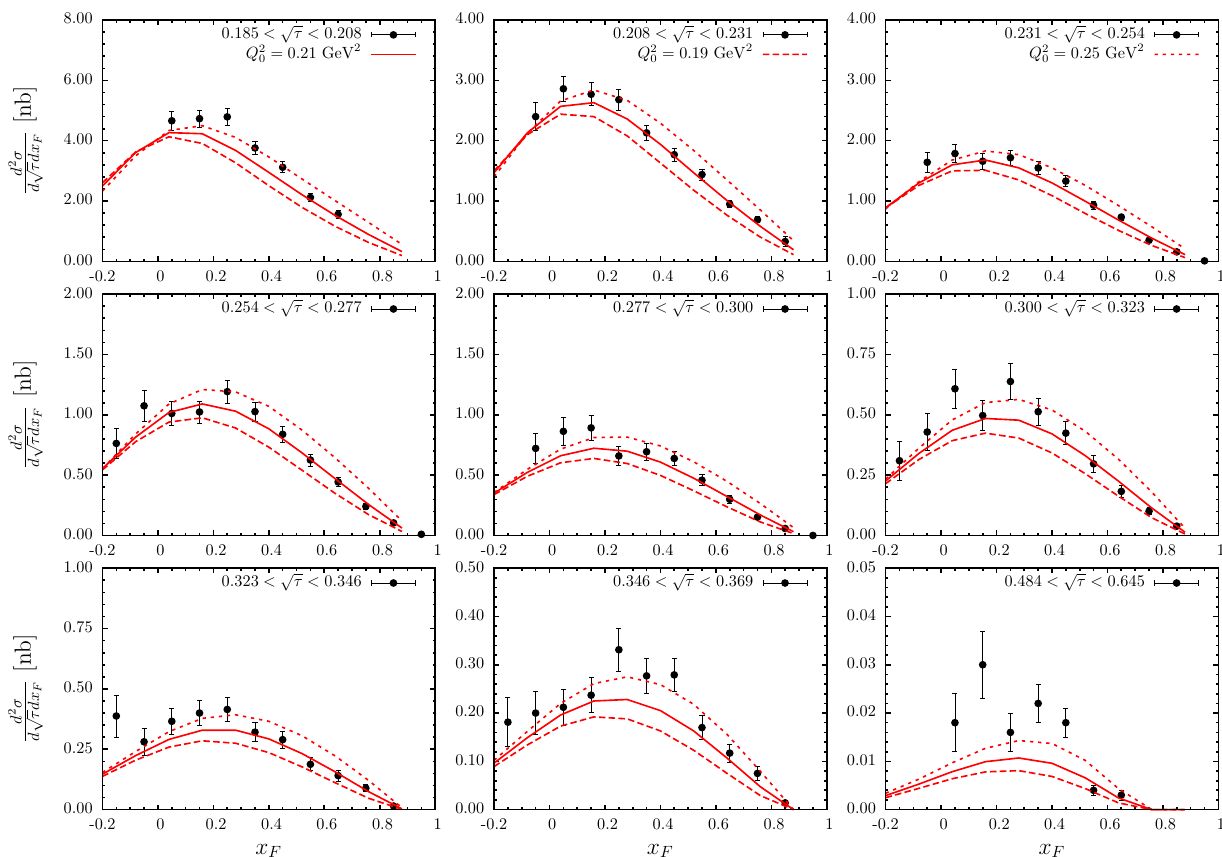
Fig. 2 Drell–Yan pairs production in π − W collisions. Next-to-leading order cross sections obtained by using evolved NJL pion PDFs for three values of Q 2 are compared to data of Ref. 0